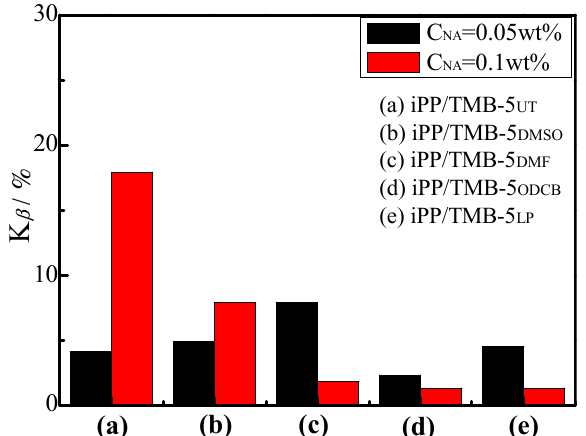
Figure 9. K β values of different TMB-5 nucleated iPP specimens: ( a ) iPP/TMB-5 UT , ( b ) iPP/TMB-5 DMSO , ( c ) iPP/TMB-5 DMF , ( d ) iPP/TMB-5 ODCB and ( e ) iPP/TMB-5 LP which statically crystallized at T c = 135 °C for 6 h after a pre-crystallization at T pc = 150 °C for 1 h, the NA content is 0.1 wt% (red column) and 0.05 wt% (black column).